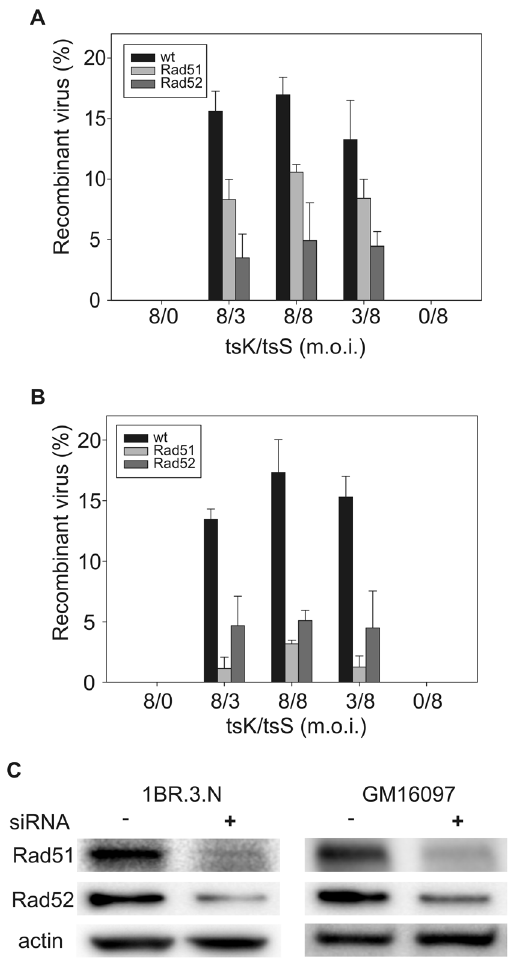
Figure 2. HSV-1 tsK and tsS recombination in 1BR.3.N and GM16097. A , Different mixtures of temperature-sensitive virus were added at the m.o.i. indicated to 1BR.3.N cells either mock-transfected or transfected with siRNA against Rad51 and Rad52. Percentage of recombinant virus was determined as the titer obtained by plaque assay on GMK-AH1 cells at 39 u C (non-permissive temperature) divided by the titer obtained at 32 6 C (permissive temperature). Recombinant virus detectable in our assay contain the U L -segment (wt UL9 gene) from tsK virus and U S -segment (wt ICP4 gene) from tsS virus. Values represent average from three independent experiments and error bars indicate standard deviation. B , Recombination in GM16097 cells examined as described above. C , Western blots demonstrating knock- down of Rad51 and Rad52 proteins in 1BR.3.N and GM16097 cells.